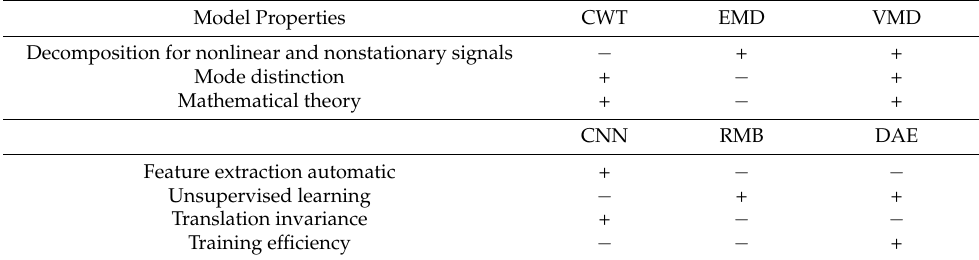
Table 1. Comparison of the state-of-the-art methods with respect to a number of properties. The + denotes a good performance and the − denotes a bad performance or complete lack